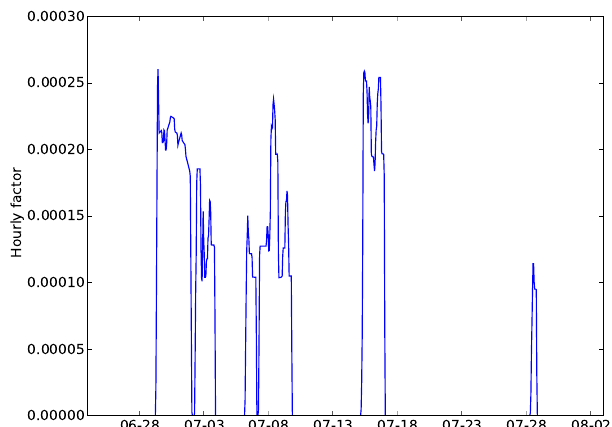
Fig. 2. Hourly factors of the emissions of the Vitry power plant. The hourly factor represents the ratio of the emission rate for a given hour to the annual emission rate. It applies to all gaseous and par- ticulate